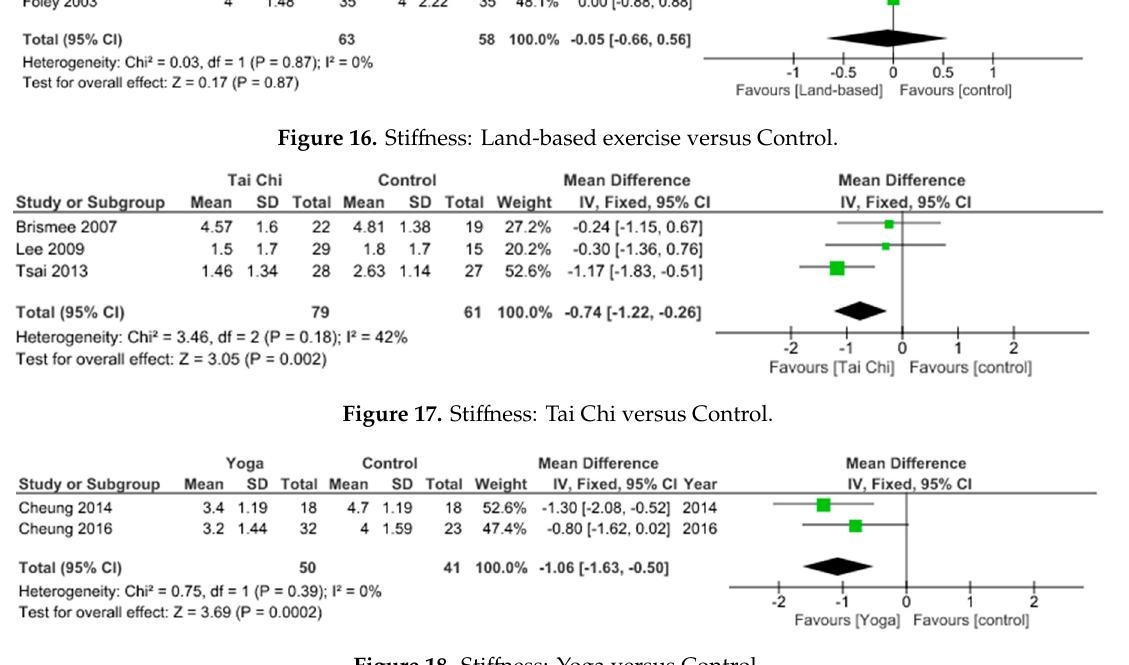
Figure 18. Sti ff ness: Yoga versus